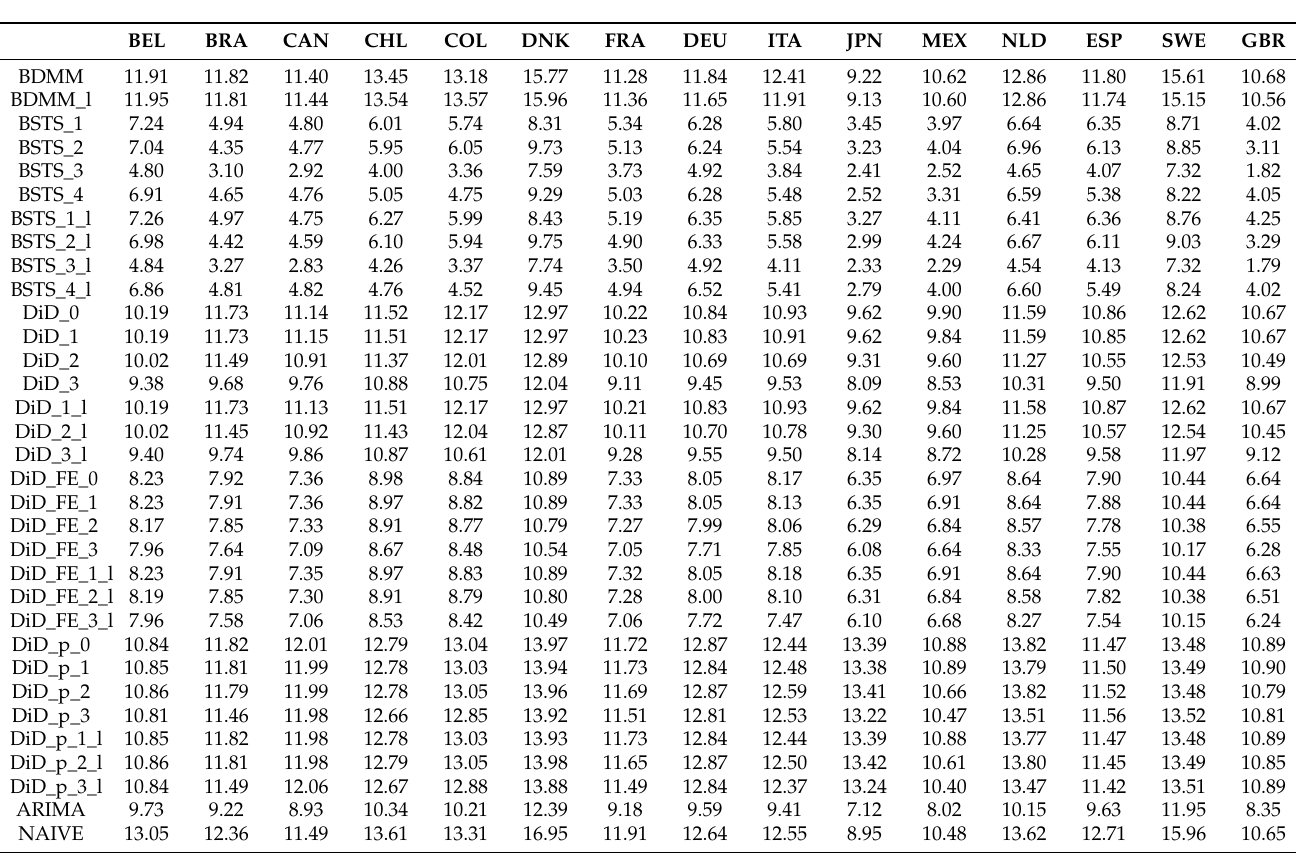
Table 3. Average values of RMSE over the